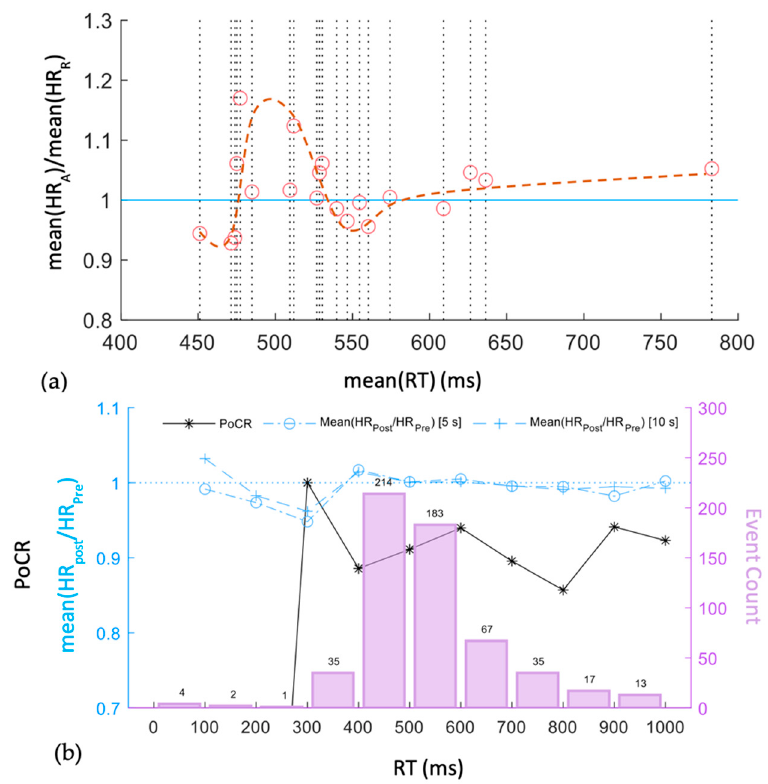
Figure 9. ( a ) Average HR change from the R to A routine as a function of RT; each circle represents a participant. ( b ) Trend analysis for each event across all participants. The PoCR is a function of RT for individual events. Trends of mean(HR Post /HR Pre ) for each event with two window sizes of 5 s and 10 s are shown in blue lines. The RT histogram across all events is shown with purple bars.